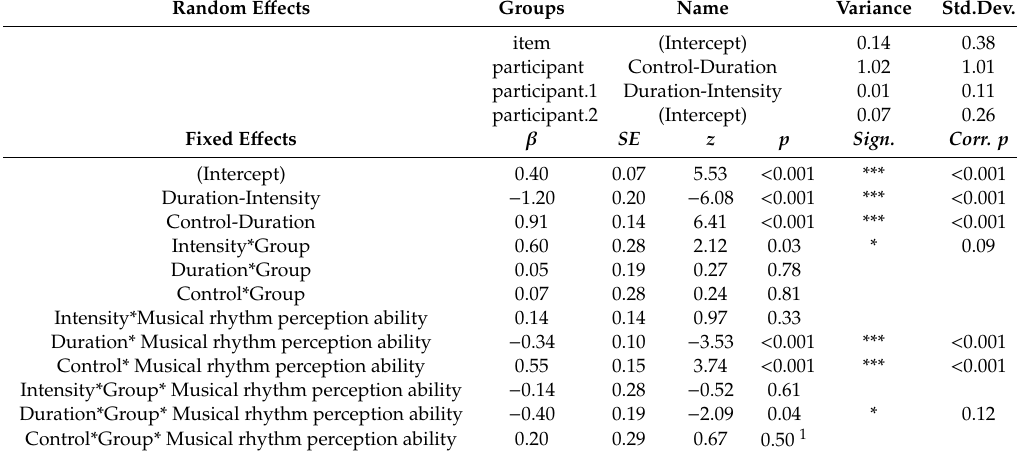
Table A7. Output of the third model exploring the e ff ects of group and musical rhythm perception ability on the three conditions.